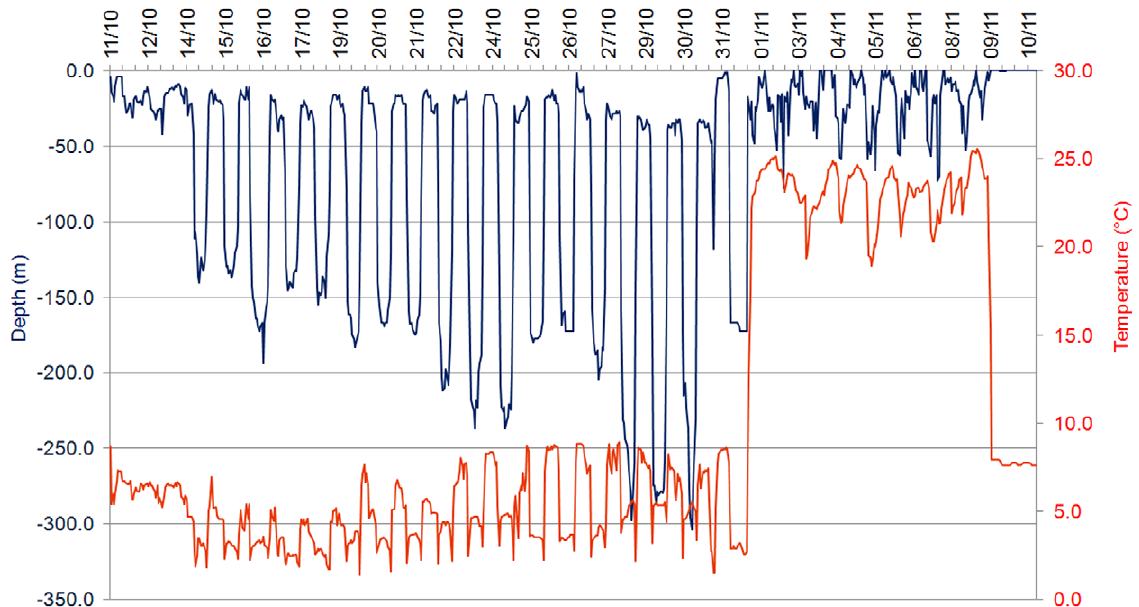
Figure 2. Vertical profile (depth & temperature) of a tagged eel ( # 110 617) illustrating the predation event and subsequent change in recorded temperature and depth (data represent one hour mean).